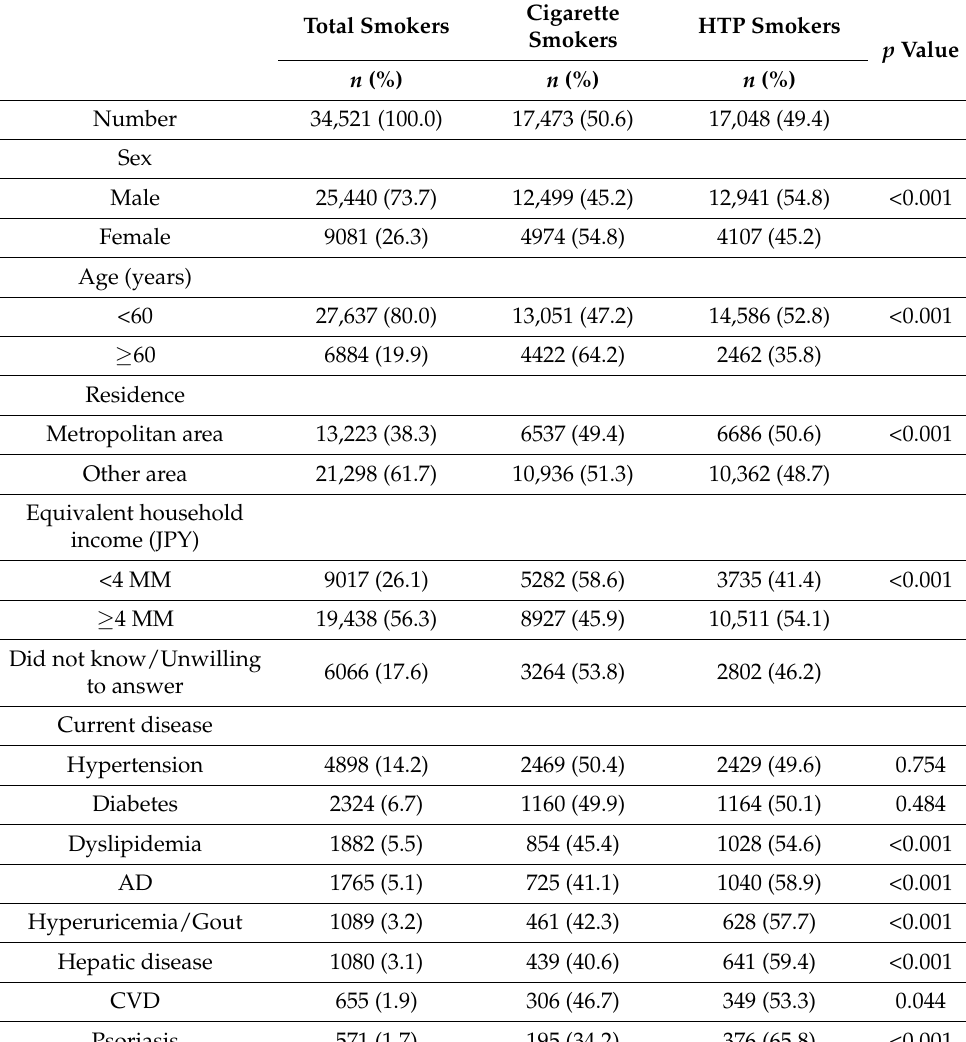
Table 1. Characteristics of participants who completed the primary